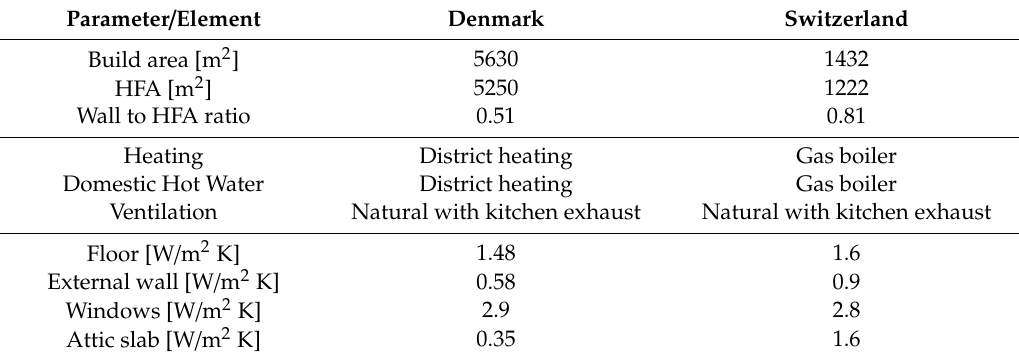
Table 2. Summary of key dimensional coefficients, existing systems, and U-values of building elements for the case study buildings.